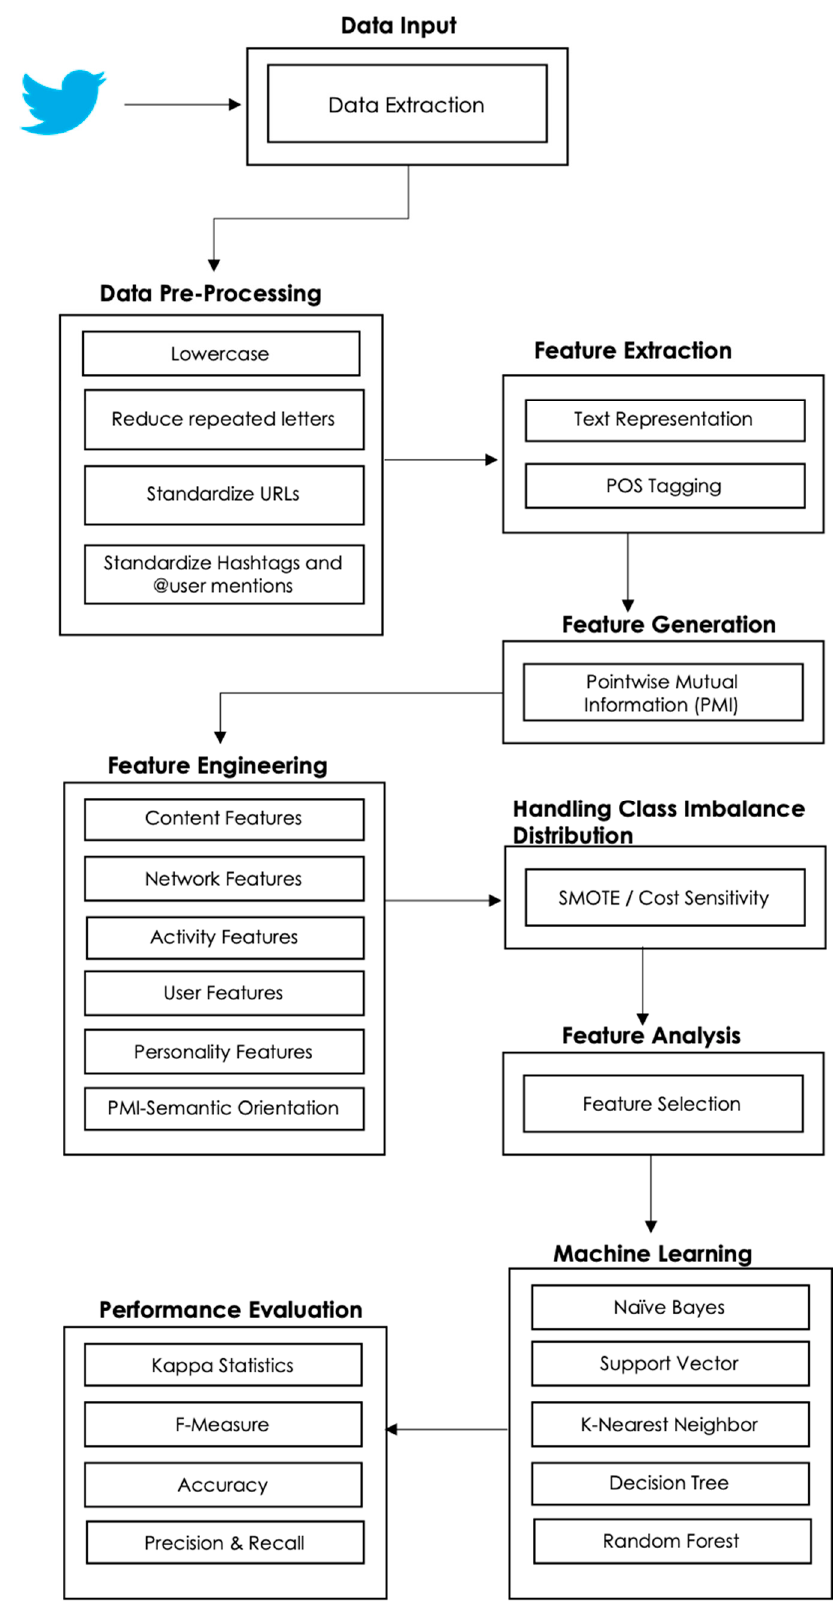
Figure 1. Overview of the methodology followed.